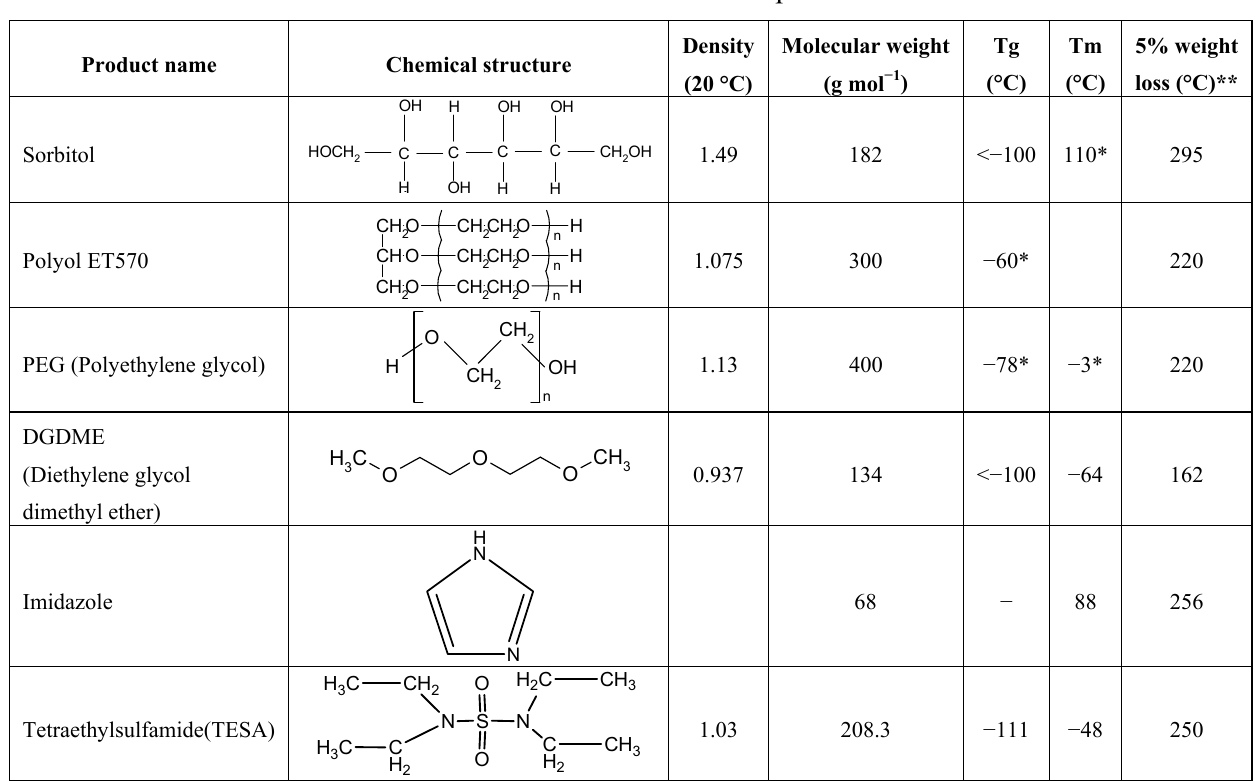
Table 2. Characteristics of the used